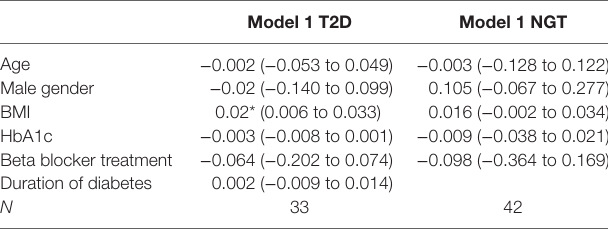
TaBle 4 | Linear regression